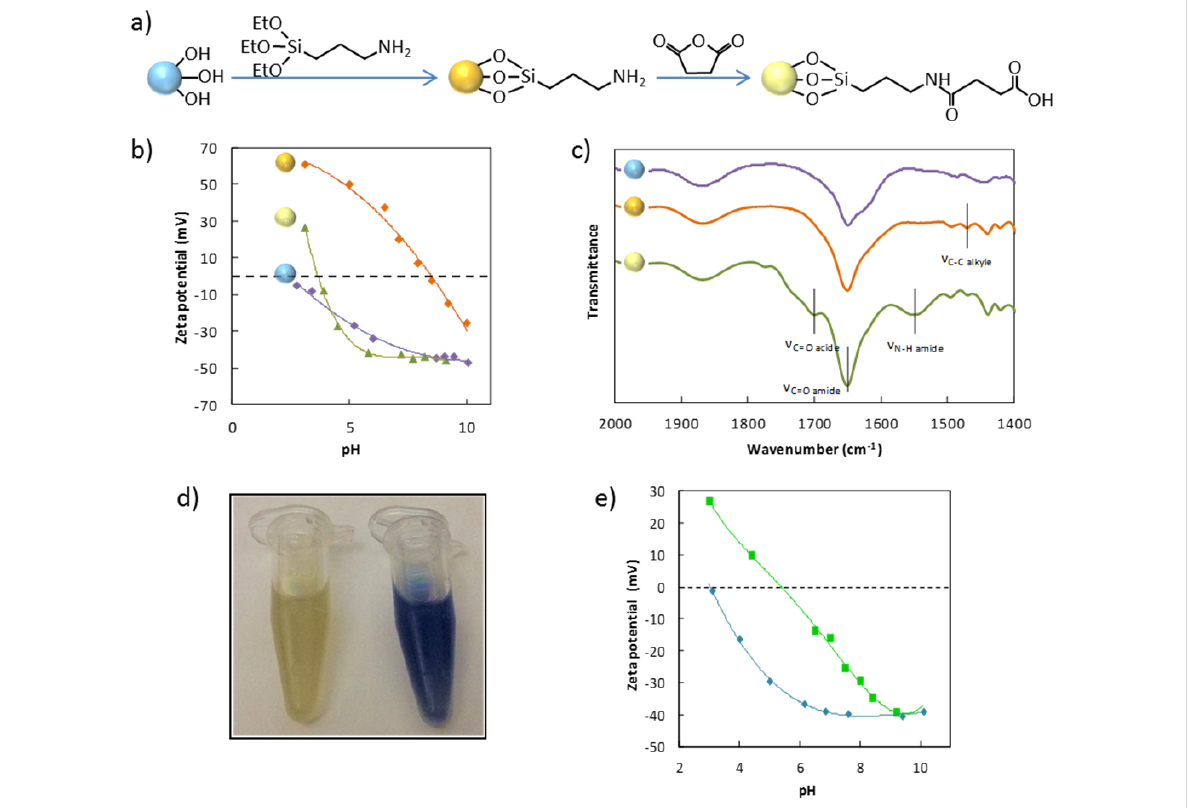
Figure 2: a) Silica surface modification with carboxylic acid groups, (b) zeta potential as a function of pH value, and (c) DRIFT spectra of bare (purple curve), aminated (orange curve) and carboxylated (green curve) silica particles; d) photograph of dimpled silica nanoparticles suspension before (left) and after (right) amination of the PS residues in the presence of ninhydrin; e) zeta potential as a function of pH value of silica particles with four dimples before (cyan curve) and after (green curve) chloromethylation and amination of the PS